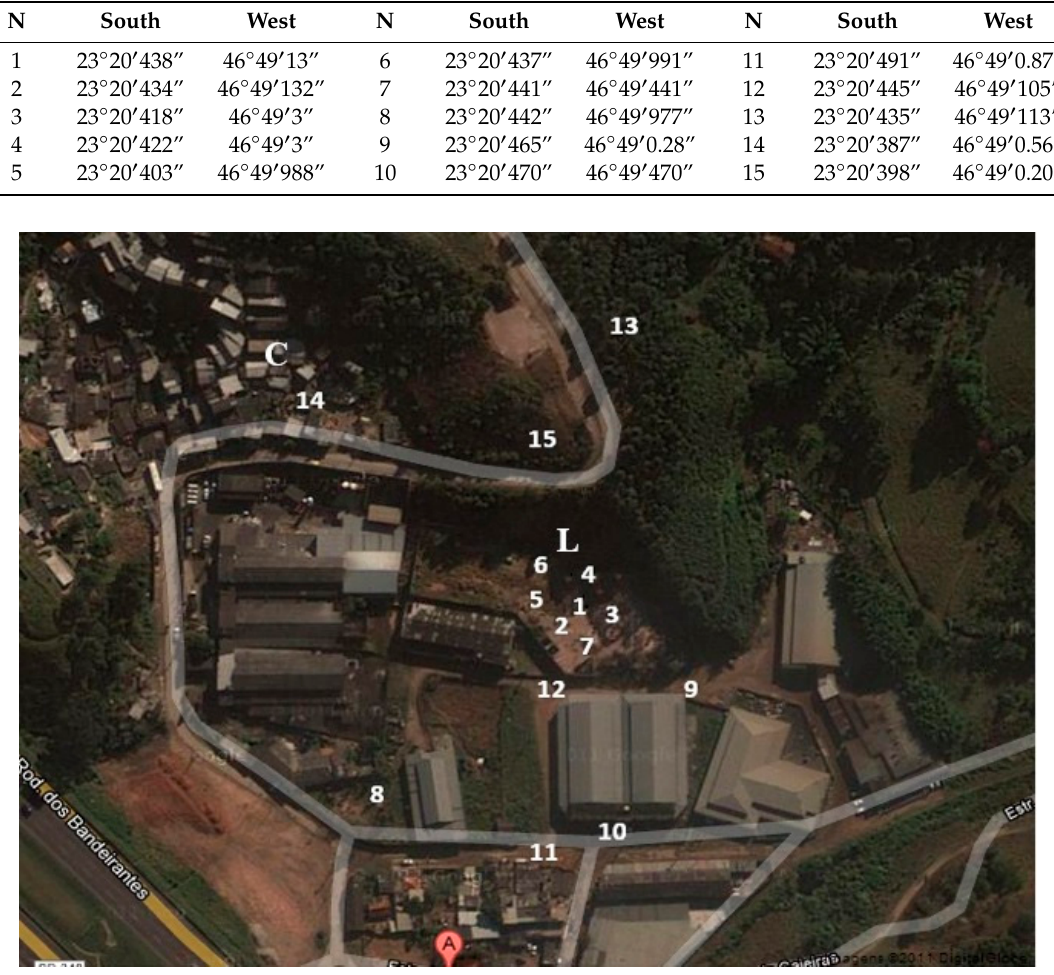
Figure 1. Image of Landfill (L) and the community (C) areas in Caieiras, SP, Brazil, in which each sampling point is shown (Picture adapted from Google Maps).